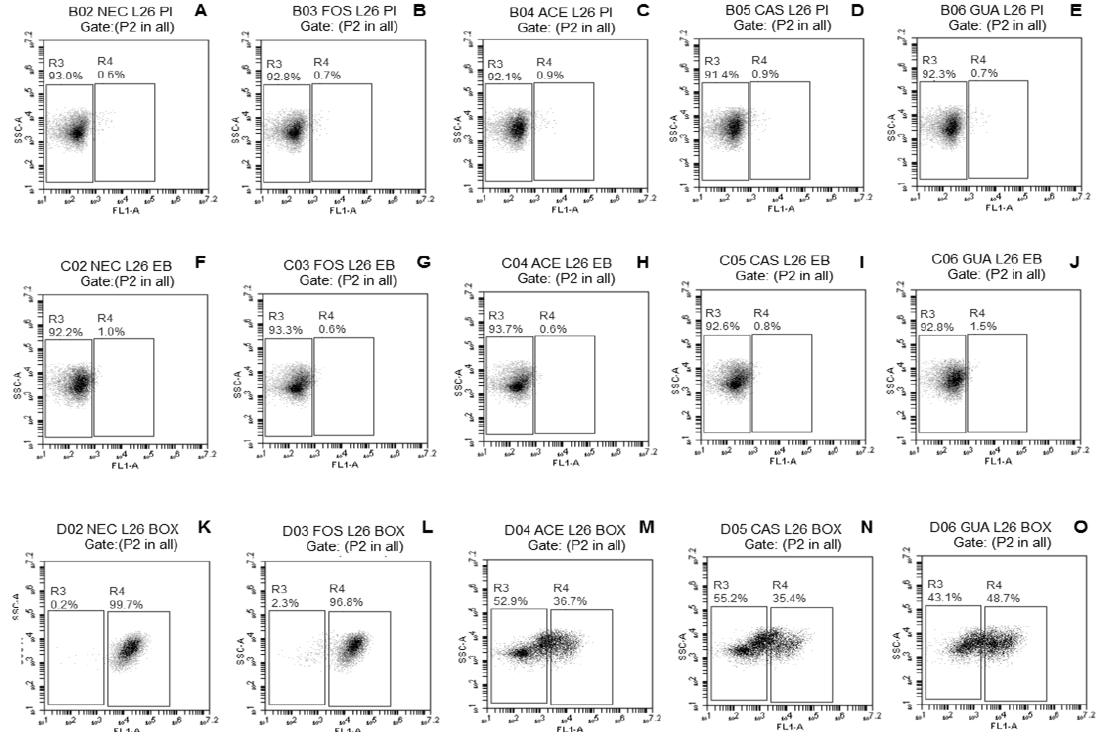
Figure 2. Fluorescence density plots of L. casei L-26 in response to staining with PI ( A – E ), EB ( F – J ), and DiBAC 4 (3) ( K – O ) after freeze- drying in the absence (NEC, ●) or presence of fructo- oligosaccharides (FOS, ■ ) or processing coproducts of acerola (ACE, □), cashew (CAS, ▵ ), or guava (GUA, ○ ). L26 — L. casei L-26. The vertical axis indicates the fluorescence intensity of PI, EB, and DiBAC 4 (3) and the intensity of lateral light dispersal. The subpopulation of negative stains was blocked in the left rectangles; the positive subpopulation of the stains was delimited in the right rectangles. The percentages of cell subpopulations that fell on each port are shown in each plot.